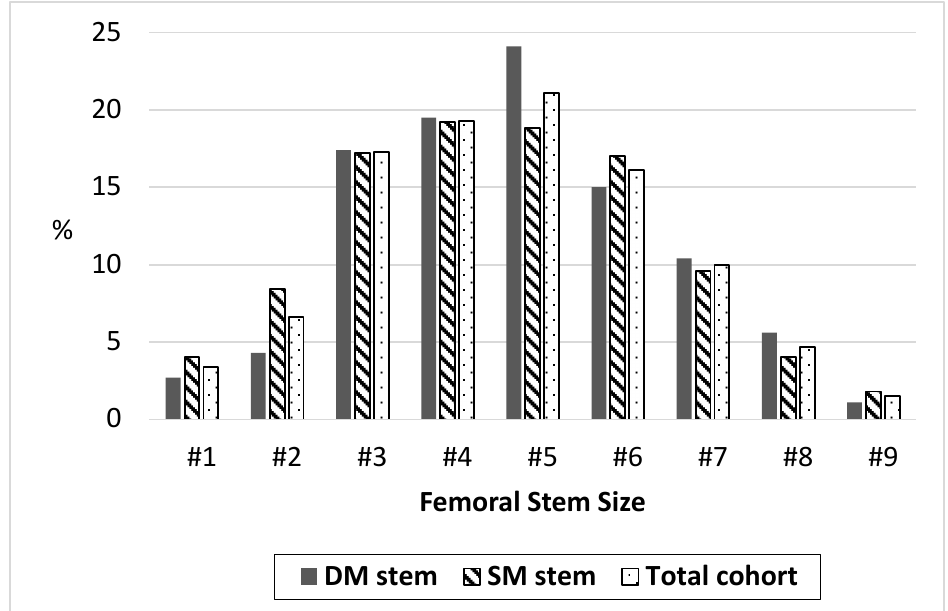
Figure 2. Femoral stem size distribution between the groups and of the total cohort (proportion from valid). DM–dual ‐ modular stem, SM–single ‐ modular stem. The median follow ‐ up for SM stem system was 8.0 years (95% CI 8.0–8.0) and 9.0 years (95% CI 9.0–9.0) for DM stem system ( p < 0.001). During the observational period, 174 patients have died. The maximum follow ‐ up was 9.9 years for all patients who were still alive on 15 November 2021. The 9 ‐ year survival rate for any reason including aseptic loosening of any component of the DM stem THA system (92.6%, 95% CI 89.9–95.3) was significantly lower than that of the SM stem THA system (97.0%, 95% CI 95.2–98.8). The